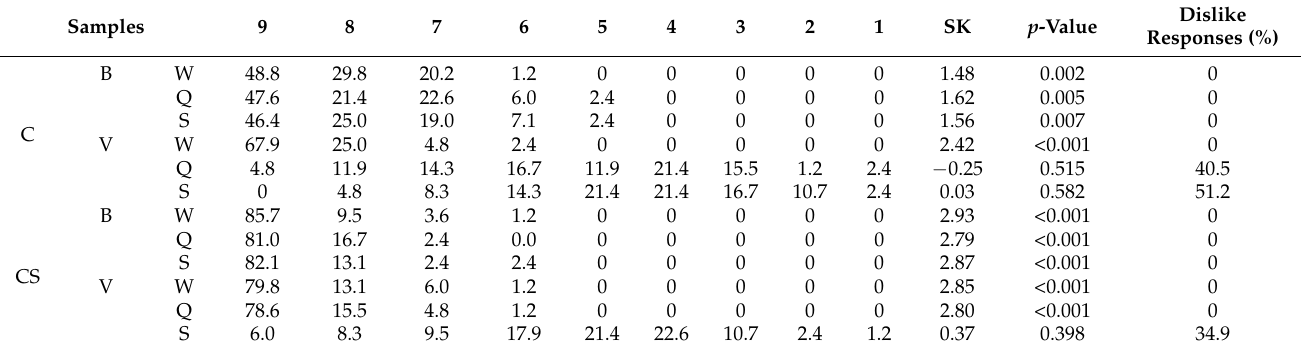
Table 3. Sensory acceptability of pasta filata cheeses from cow’s milk and its mixture with sheep’s milk.